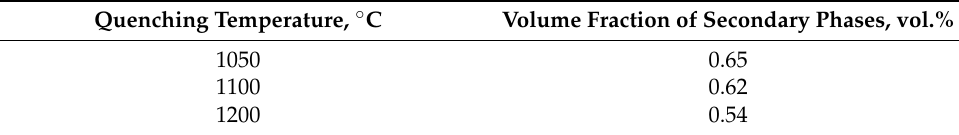
Figure 5. Microstructures of Steel 4: ( a ) secondary phase identification after etching with Beraha’s reagent; ( b , c ) SEM images. Table 6. Evaluating the volume fraction of secondary phases in Steel 4.